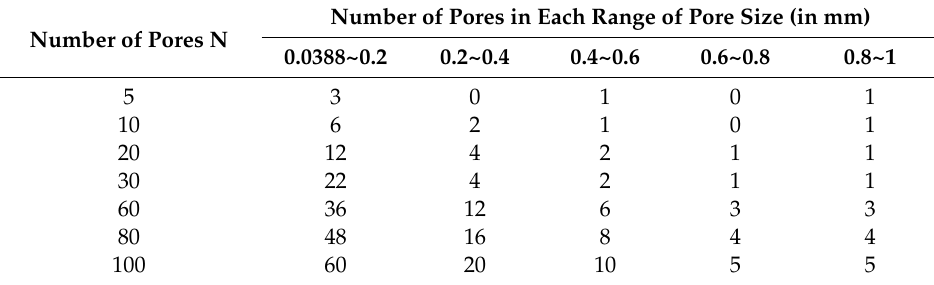
Table 8. Pore size distribution in the RVE for N between 5 and 100. Number of Pores in Each Range of Pore Size (in Number of Pores N